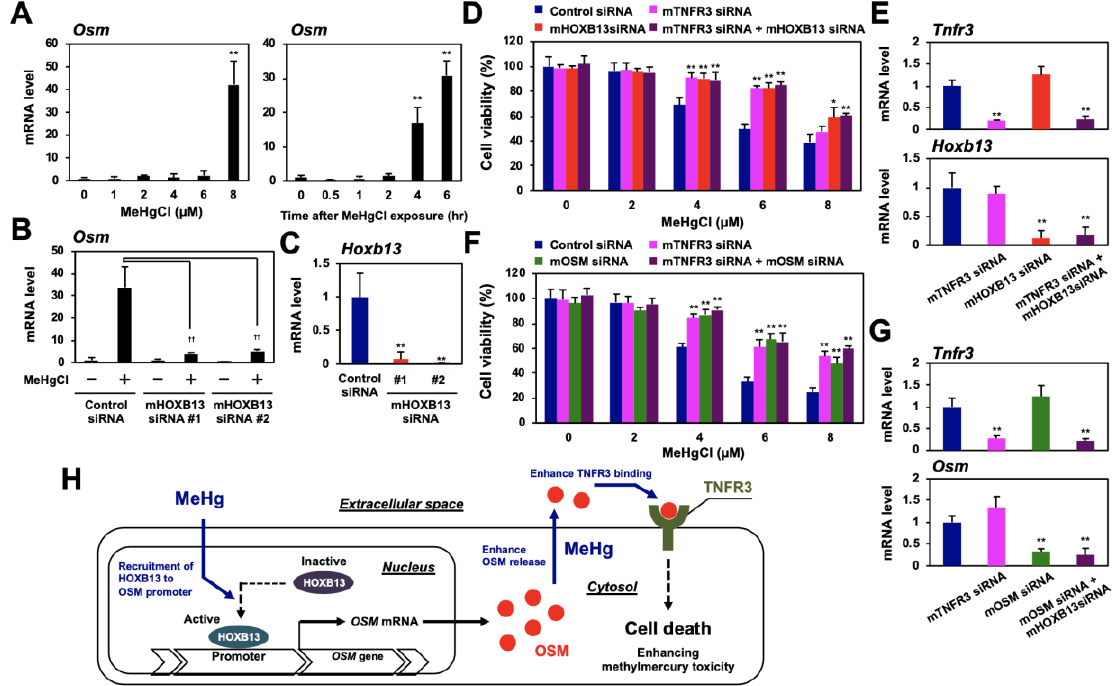
Figure 7. Involvement of HOXB13, OSM, and TNFR3 in methylmercury toxicity in mouse neural stem cells C17.2. ( A ) C17.2 cells were exposed to the indicated concentrations of methylmercuric chloride (MeHgCl) for 6 h (left panel) or to 8 µ M MeHgCl for the indicated time course (right panel). OSM mRNA levels were determined by qPCR. Representative data indicate relative values, with control as 1, normalized to each GAPDH mRNA level. ( B , C ) Cells were transfected with two di ff erent sequences of mouse (m) HOXB13 siRNAs (#1 or #2) for 48 h. Cells were exposed to MeHgCl (8 µ M) for 6 h, and mRNA levels of OSM and HOXB13 were determined. Representative data indicate the relative values, with control as 1, normalized to each GAPDH mRNA level. ( D ) Cells were transfected with control siRNA, mTNFR3 siRNA, and / or mHOXB13 siRNA (#2) for 48 h and exposed to indicated concentrations of MeHgCl for 24 h. Cell viability was measured by alamarBlue assay. No significant di ff erence was found between mHOXB13 siRNA and mTNFR3 siRNA + mHOXB13 siRNA. ( E ) Quantitative PCR for TNFR3 (upper panel) or HOXB13 (lower panel) was performed. Representative data indicate the relative values, with control as 1, normalized to each GAPDH mRNA level. ( F ) Cells were transfected with control siRNA, mTNFR3 siRNA, and / or mOSM siRNA for 48 h and exposed to the indicated concentrations of MeHgCl for 24 h. Cell viability was measured by alamarBlue assay. No significant di ff erence was found between mTNFR3 siRNA and mTNFR3 siRNA + mOSM siRNA. ( G ) qPCR for TNFR3 (upper panel) or OSM (lower panel) was performed. Representative